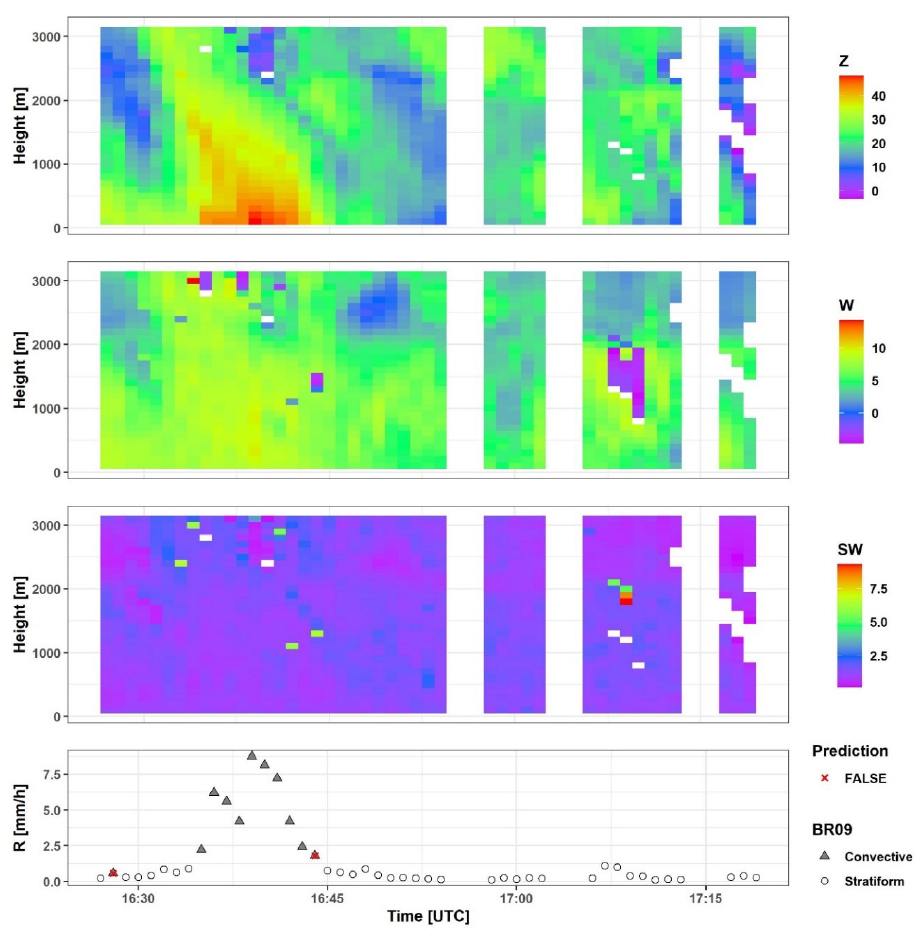
Figure A2. Event 186. The upper three panels represent the MRR measured values of reflectivity Z (dBZ), Doppler velocity W (m/sec), and spectral width SW (m/sec) respectively. The last panel represents rain intensity R (mm/h) as measured by the